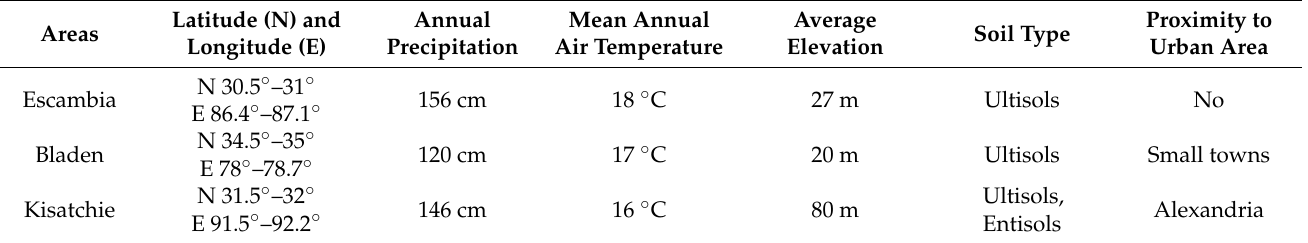
Table 1. In this region, the distance of half-degree latitude or longitude is about 50 km. Table 1. The basic information of three areas with active restoration of longleaf pine